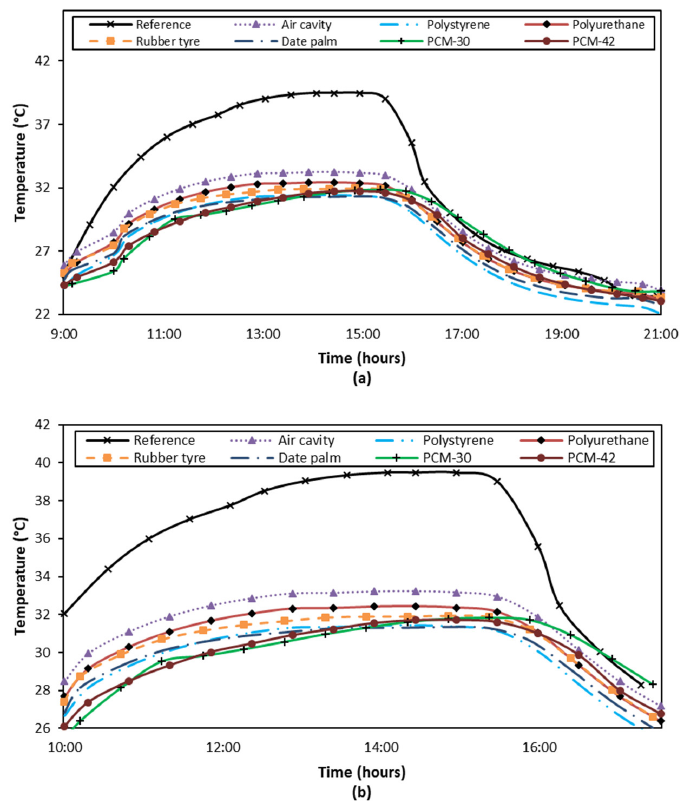
Figure 4. Thermal performance curves for back surface, ( a ) from start to end and ( b ) at the steady state.